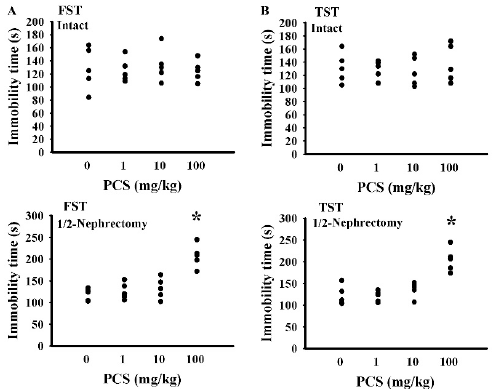
Figure 2. PCS caused alterations in nephrectomized mice. The intact and unilateral nephrectomized (1/2-Nephrectomy) mice were intraperitoneally injected with various doses of PCS for 7 weeks. The forced swimming test (FST) ( A ) and tail suspension test (TST) ( B ) were conducted and the duration of immobility was recorded. * p < 0.05 vs. control group without PCS, n =